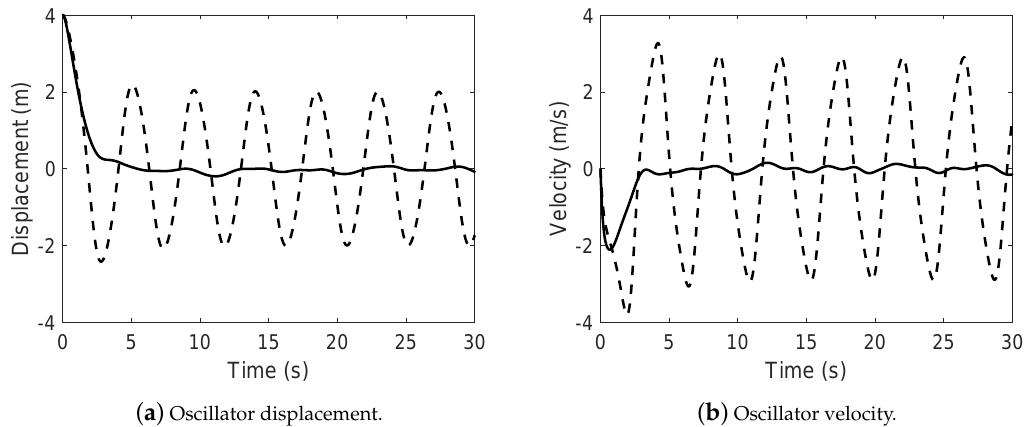
Figure 4. Uncontrolled motion (dashed line) and feedforward controlled motion (solid line).